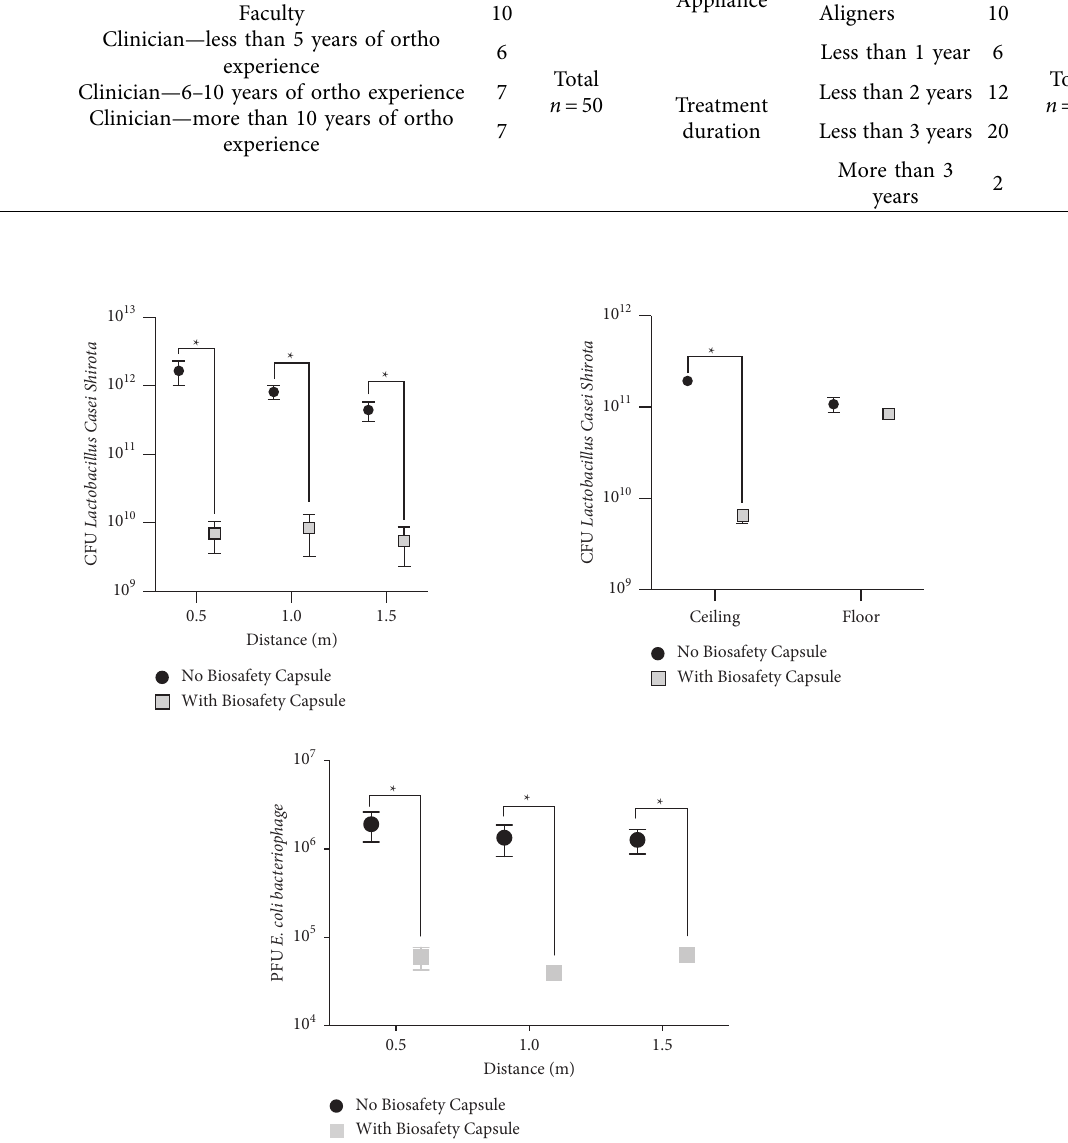
Figure 3: Aerosol production with and without the individual biosafety capsule device (IBCD) using Lactobacillus and E. coli